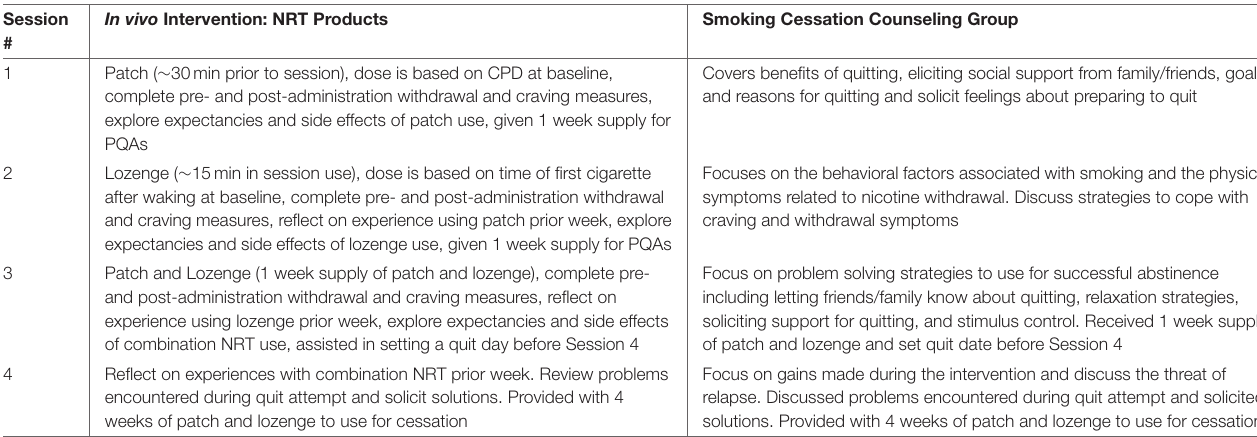
TABLE 2 | Session information by group. In vivo Intervention: NRT Products Smoking Cessation Counseling Session #